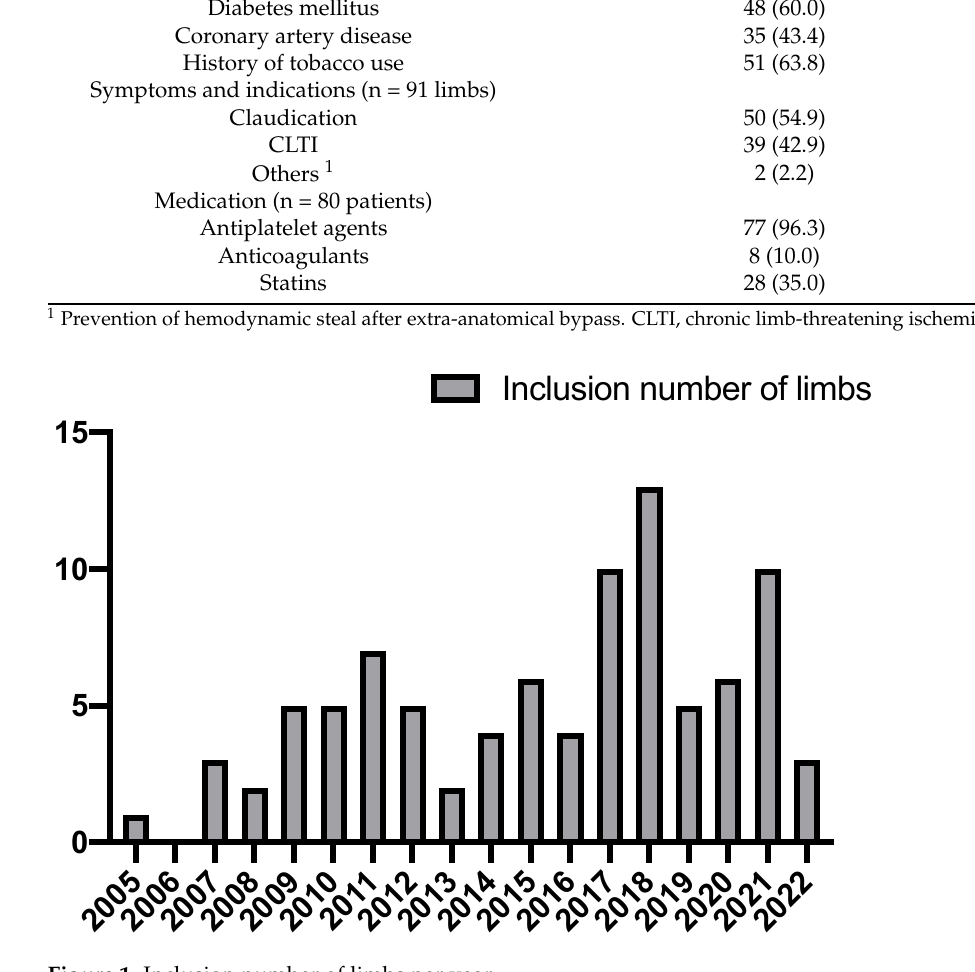
Figure 1. Inclusion number of limbs per year.